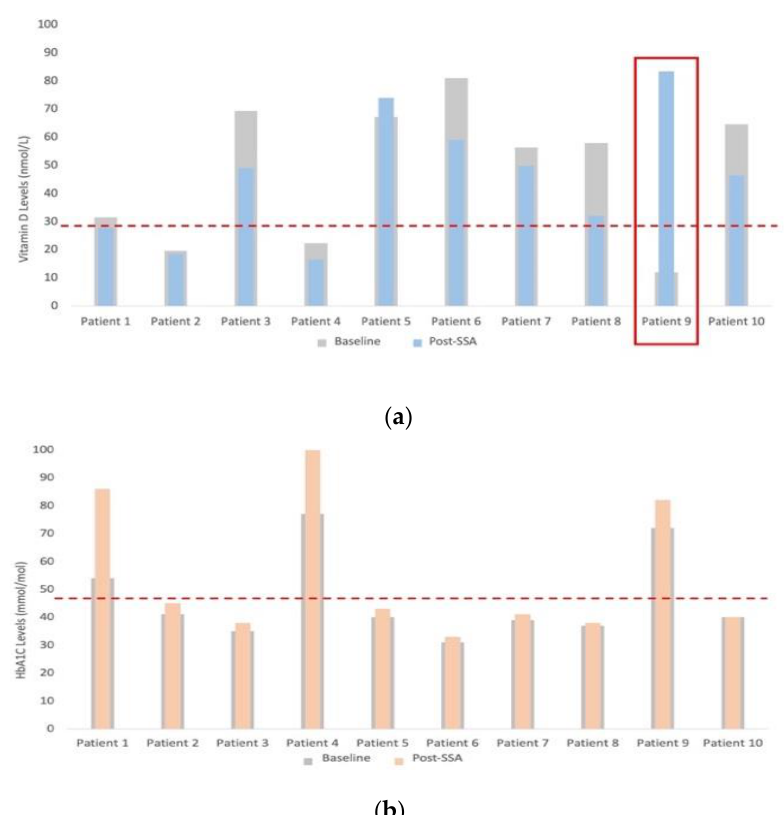
Figure 3. ( a ) Bar graph of change in vitamin D (nmol/L), where a threshold of <29 nmol/L was considered deficient (patient 9 was given vitamin D supplementation between measurements and was thus excluded from the final analysis); ( b ) bar chart of change in HbA1C (mmol/mol), where a threshold of >48 mmol/mol was considered raised. Grey bars represent baseline values.